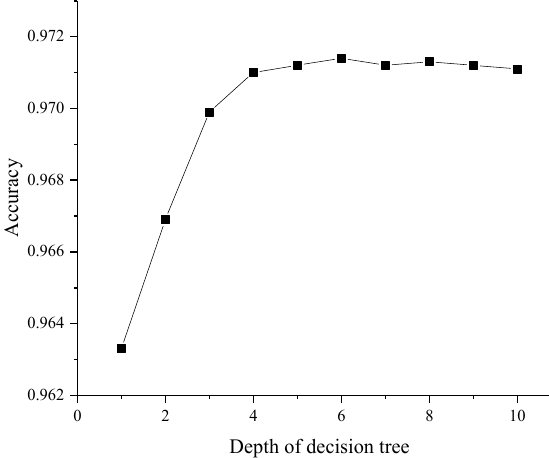
Figure 6. Optimization of decision tree depth.